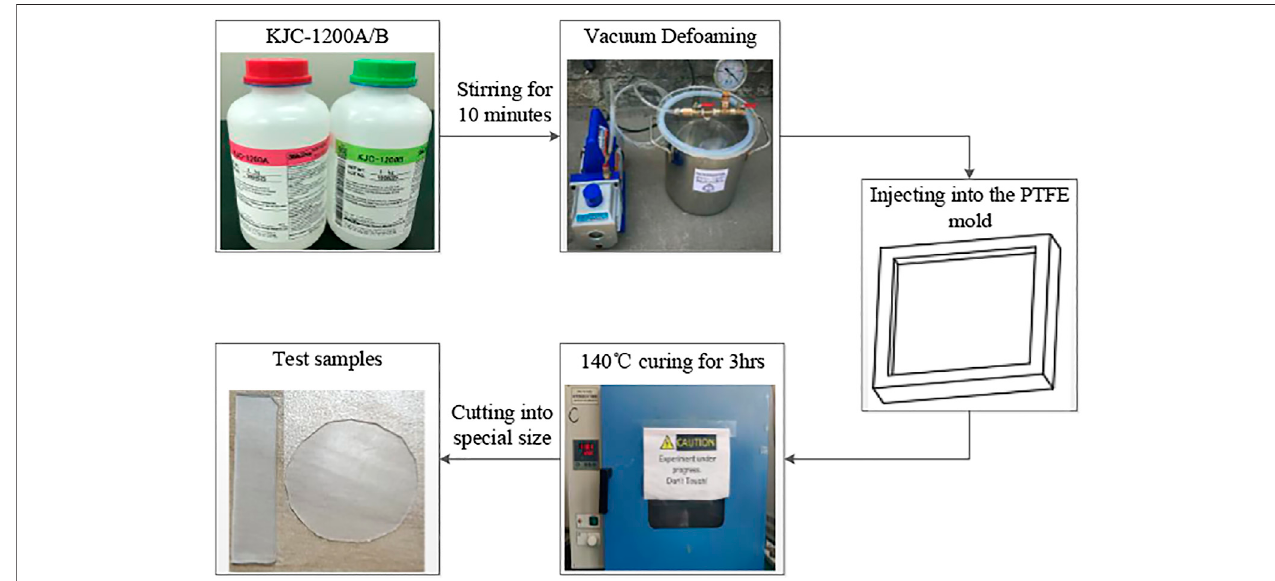
FIGURE 1 | Test samples preparation procedure.